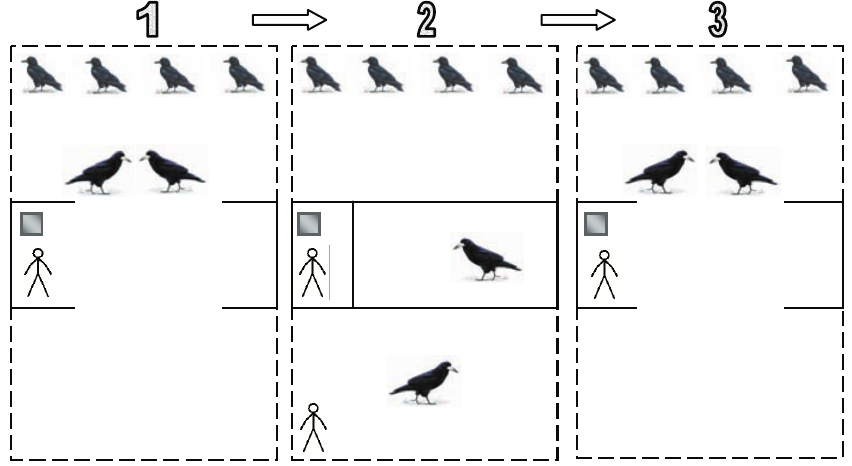
Fig. 2. Condition 2. The set up is the same as in condition 1, with an exception during the separation phase (2), where both partners were separated from the group. Solid lines represent visually isolated compartments, dashed lines indicate wire